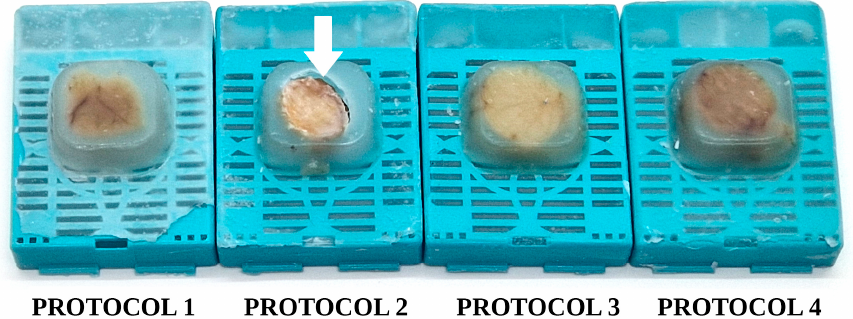
Figure 5. Testes “donor” paraffin blocks: Protocol 1–Protocol 4. White arrow: depression of the tissue samples within the paraffin block, a clear sign of excessive residual water/insufficient tissue processing.